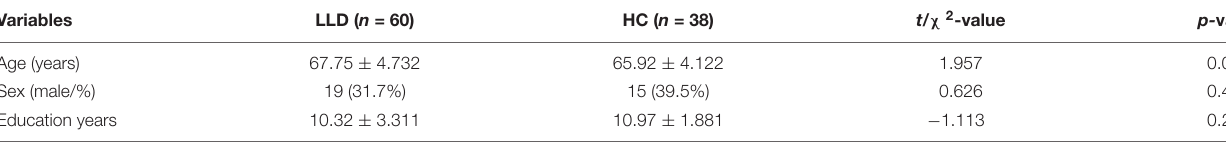
TABLE 1 | The demographic and clinical characteristics of the LLD and HC group.